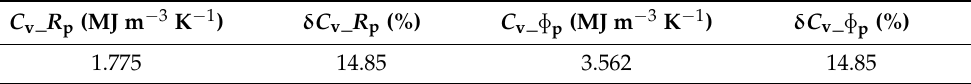
Table 8. Heat capacity value deduced with TD from Table 7 and TC from the cooling period, and related uncertainties δ